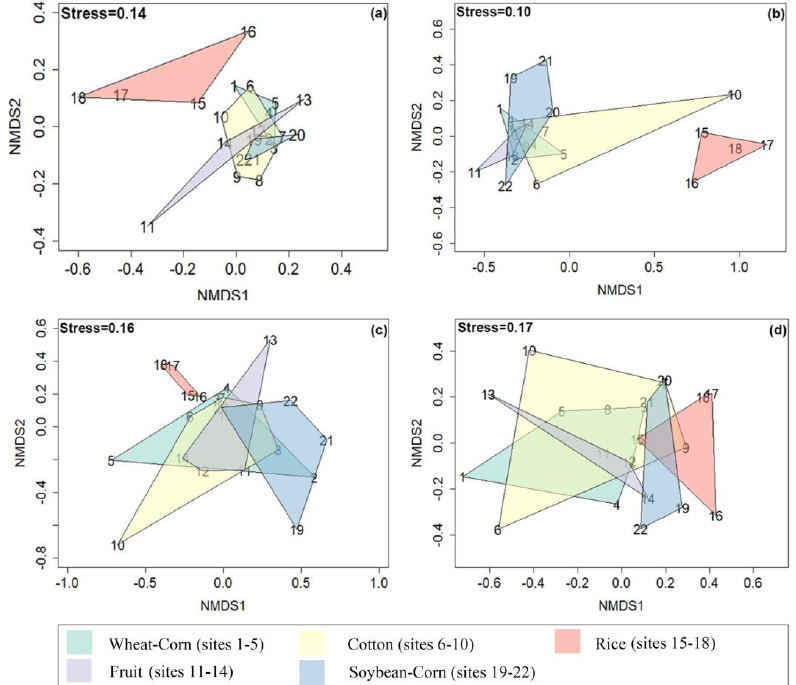
Figure 2. Non – Metric Multidimensional Scaling (NMDS) analysis of amplicon profiles of 16S rRNA